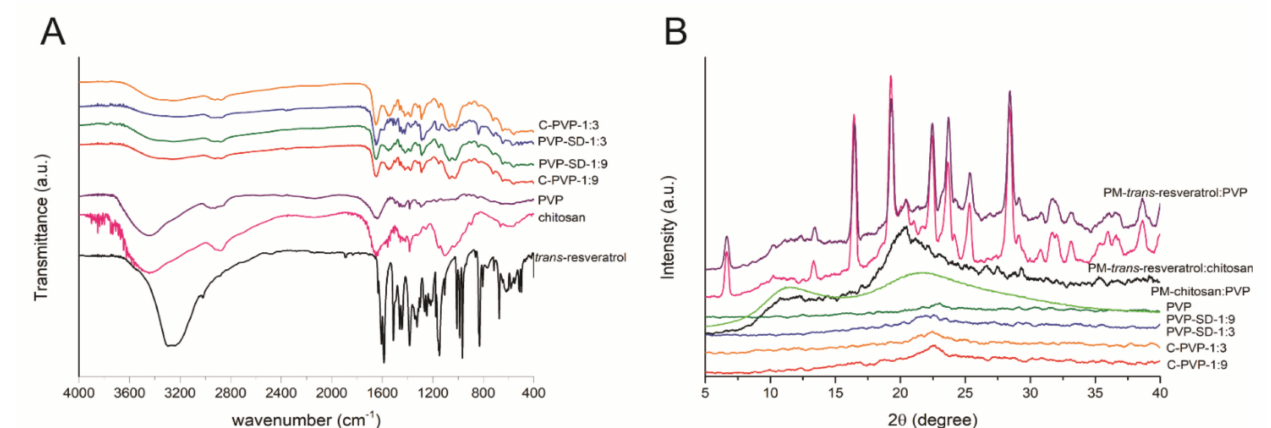
Figure 2. Physicochemical properties of raw materials, physical mixtures (PM), and membranes: ( A ) FTIR spectra; ( B ) DRX diffractograms.